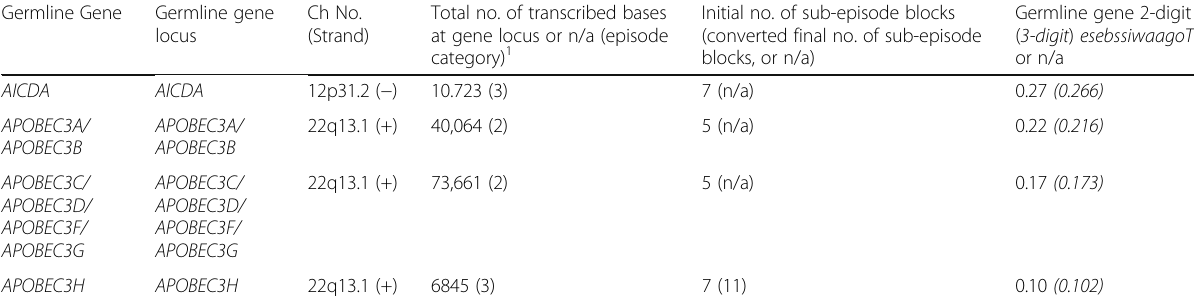
Table 13 Chromosome 12 ( − ) strand chromatin consensus sequence recognition (CSR) and somatic hypermutation (SHM) enzyme gene, AICDA , esebssiwaagoT , and chromosome 22 (+) strand CSR and SHM genes, APOBEC3A through APOBEC3H , esebssiwaagoT Q s for pressuromodulation mapping of B-cell differentiation Germline Gene Germline gene